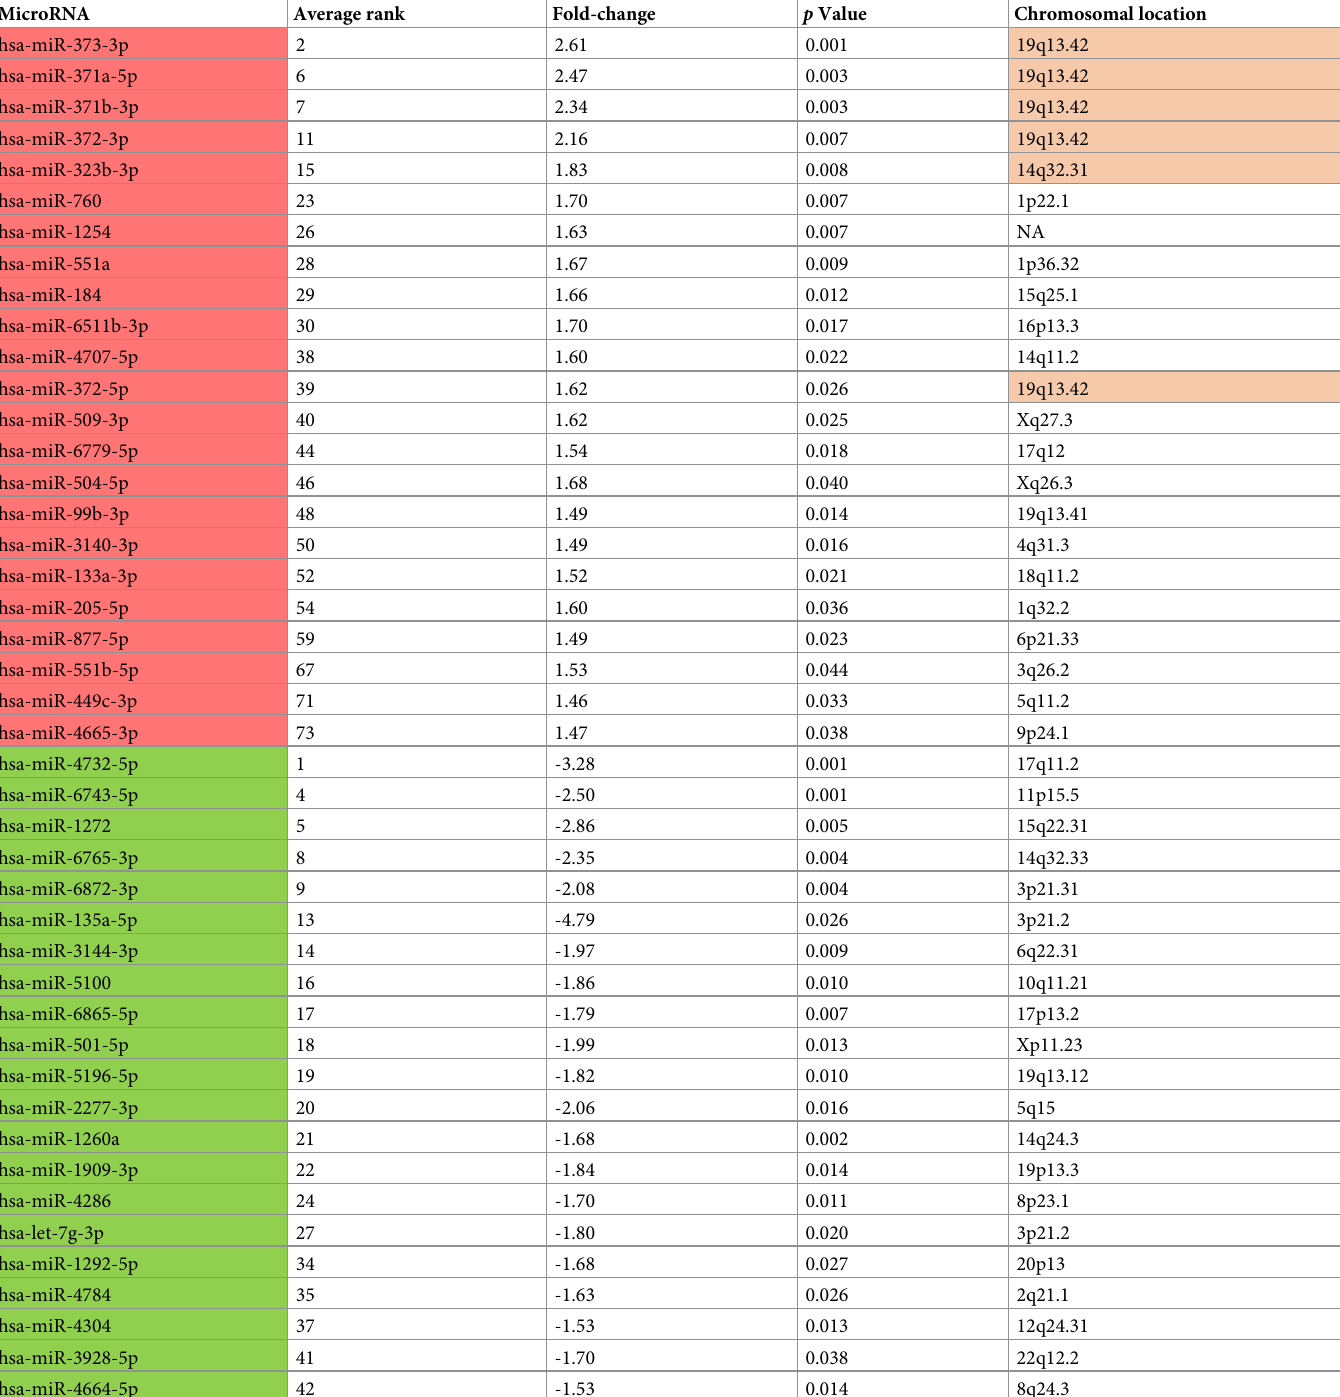
Table 1. Up- and downregulated human placenta miRNAs at spontaneous term labor. MiRNAs isolated from human placenta after spontaneous term labor were com- pared with miRNAs of placentas obtained from elective deliveries by caesarean section without signs or symptoms of labor. Thresholds used in filtering differentially expressed miRNAs were fold-change (FC) more or less than 1.5 and p value < 0.05. MiRNAs were ranked based on both t -test p value and FC. In the average rank column, the value 1 is the strongest differentially expressed miRNA. Up- and downregulated miRNAs are shown in red and green, respectively. Chromosomal locations of miRNAs belonging to either C14MC or miR-371-3 cluster are highlighted in